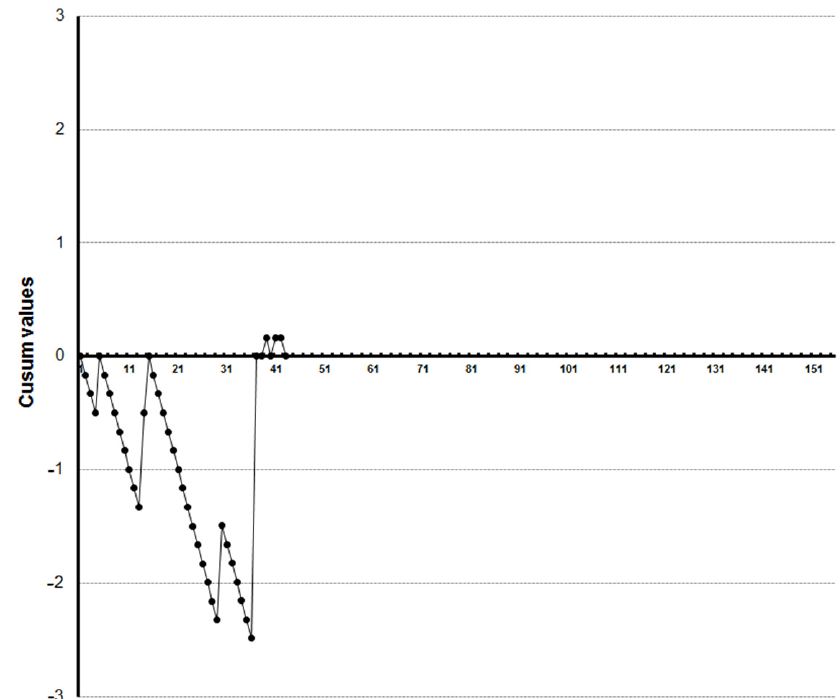
Figure 8. LC-CUSUM curve for trainee four. This trainee reached competence but did not keep it in the cumulative analysis. One trainee did not reach competence after visualizing the 45 videoclips (Figure 9).